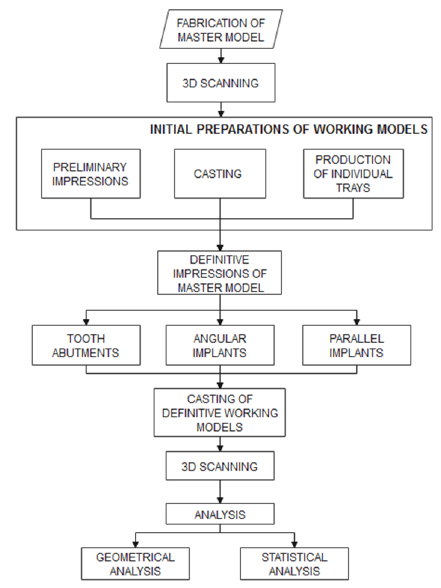
Figure 1. Methodology workflow.